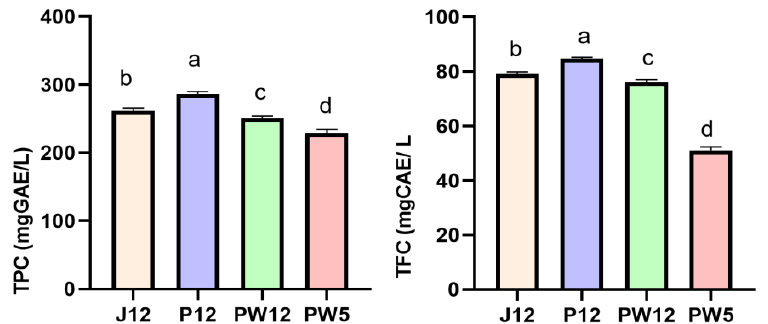
Figure 1. Total phenolic and total flavonoid contents of the investigated wines. Values are the averages of three replicates, and different alphabets indicate significant differences ( p < 0.05) according to Duncan test.